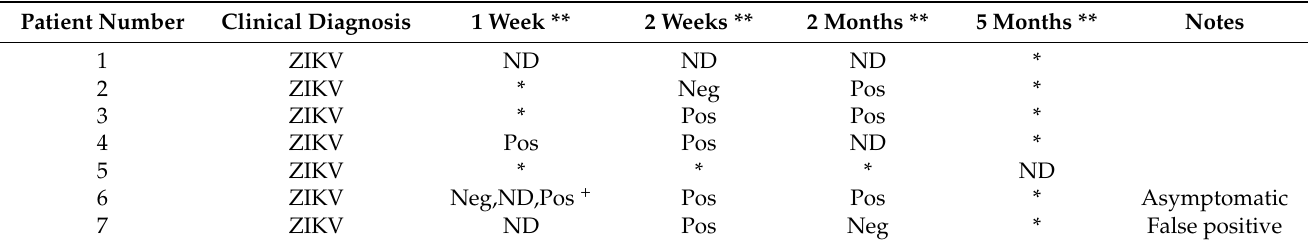
Table 2. Results from characterized Chilean samples using peptide-based